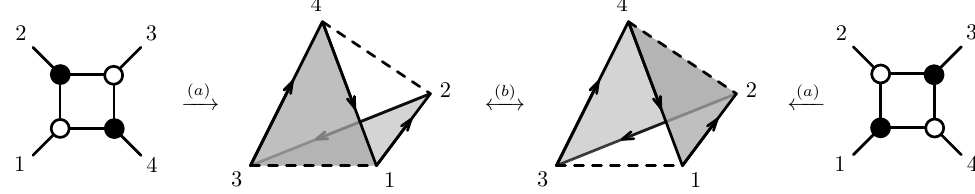
Figure 3 . Square move as the simplest example of a sphere move. (a) Translation between on-shell diagrams and triangulations of spheres. (b) On the l.h.s. we have T L = f (1 ; 2 ; 3) ; (1 ; 3 ; 4) g , while on the r.h.s. we have T R = f (1 ; 2 ; 4) ; (2 ; 3 ; 4) g . Both of their boundaries give the same 1-complex associated to the oriented edge set f (12) ; (23) ; (34) ; (41) g . Note that edges (13) and (24) cancel on both sides. Algebraically, we have (cid:1) 123 + (cid:1) 134 = (cid:1) 124 + (cid:1) 234 = u 12 + u 23 + u 34 + u 41